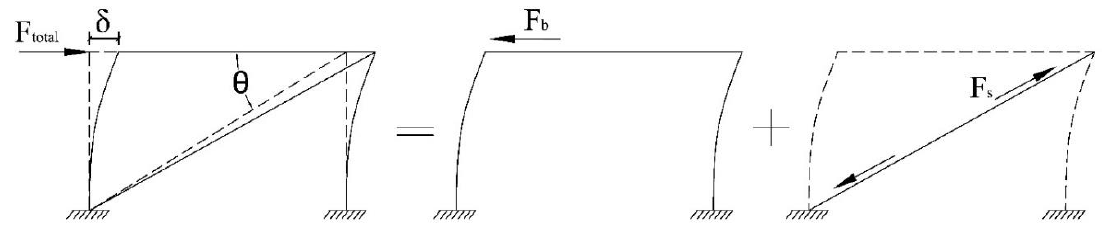
Figure 16. Separate contribution of module and strut in lateral load-bearing.